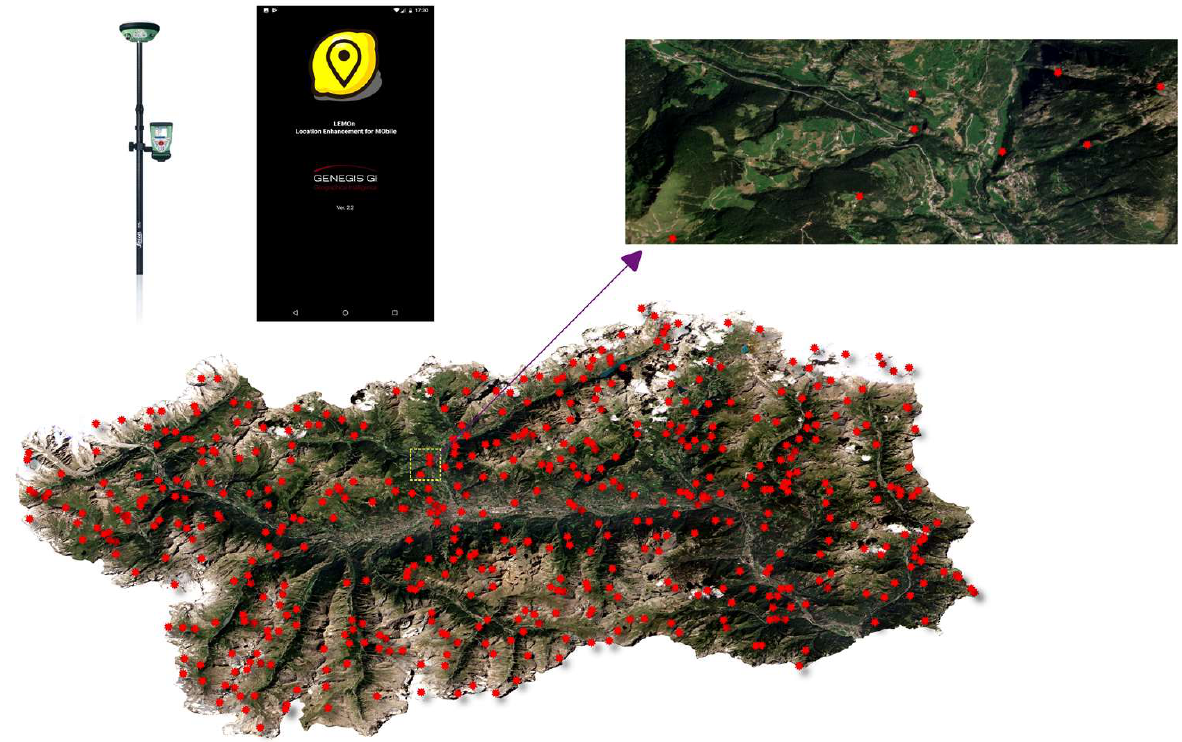
Figure 2. GNSS points detected and adopted a part as training set and another as validation